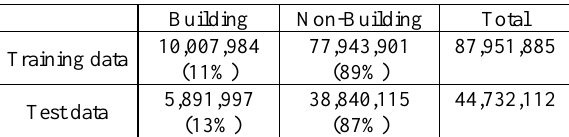
Table 1. The number of points in the training and the test